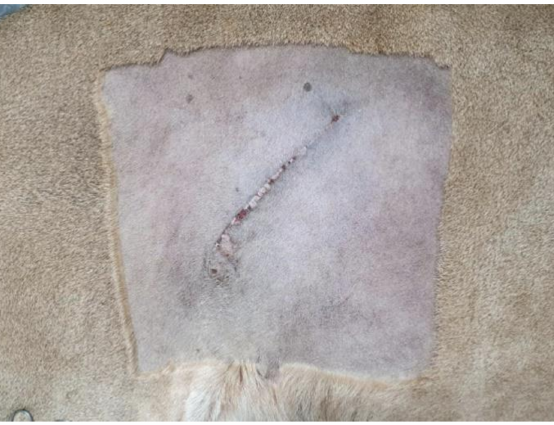
Figure 6. Surgical site 16 days after ovariohysterectomy with lateral flank